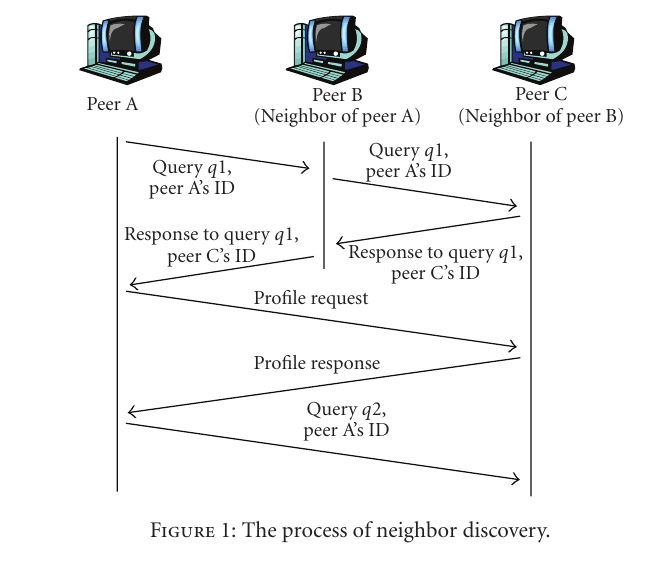
Figure 1: The process of neighbor